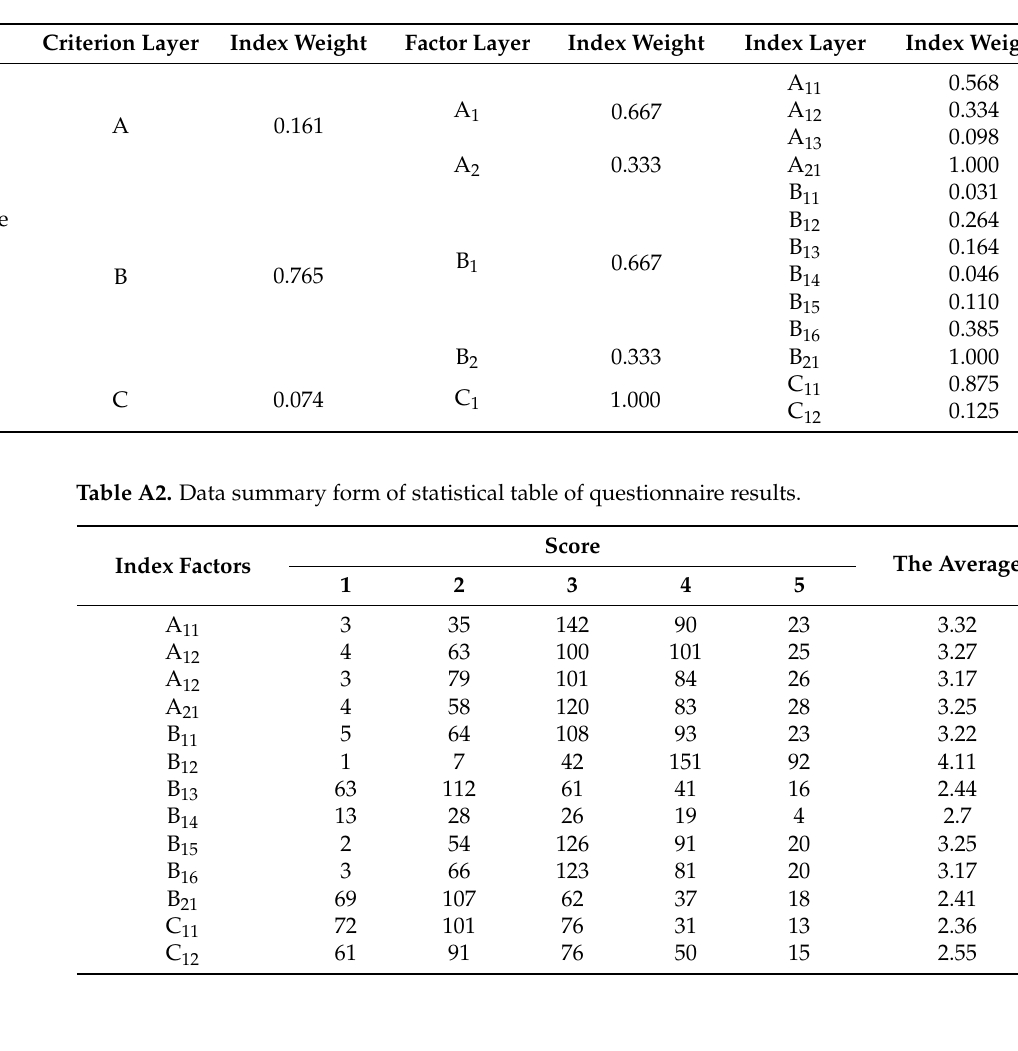
Table A1. Data summary form of the index weight of comprehensive evaluation index system.